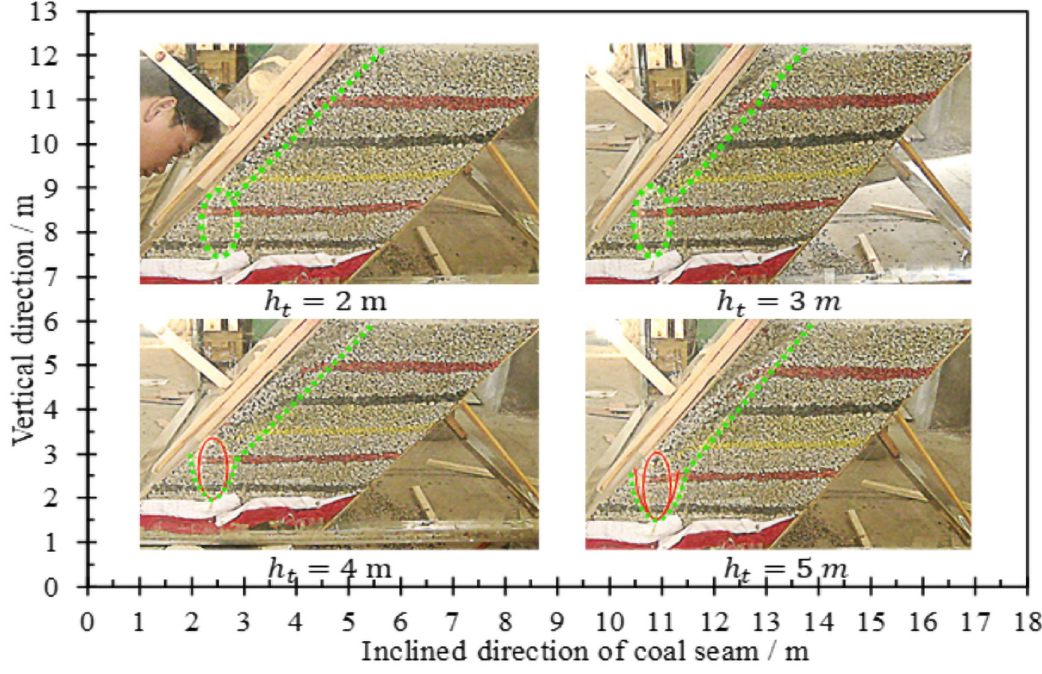
Fig 6. Loose form and discharging process of coal (on the strike